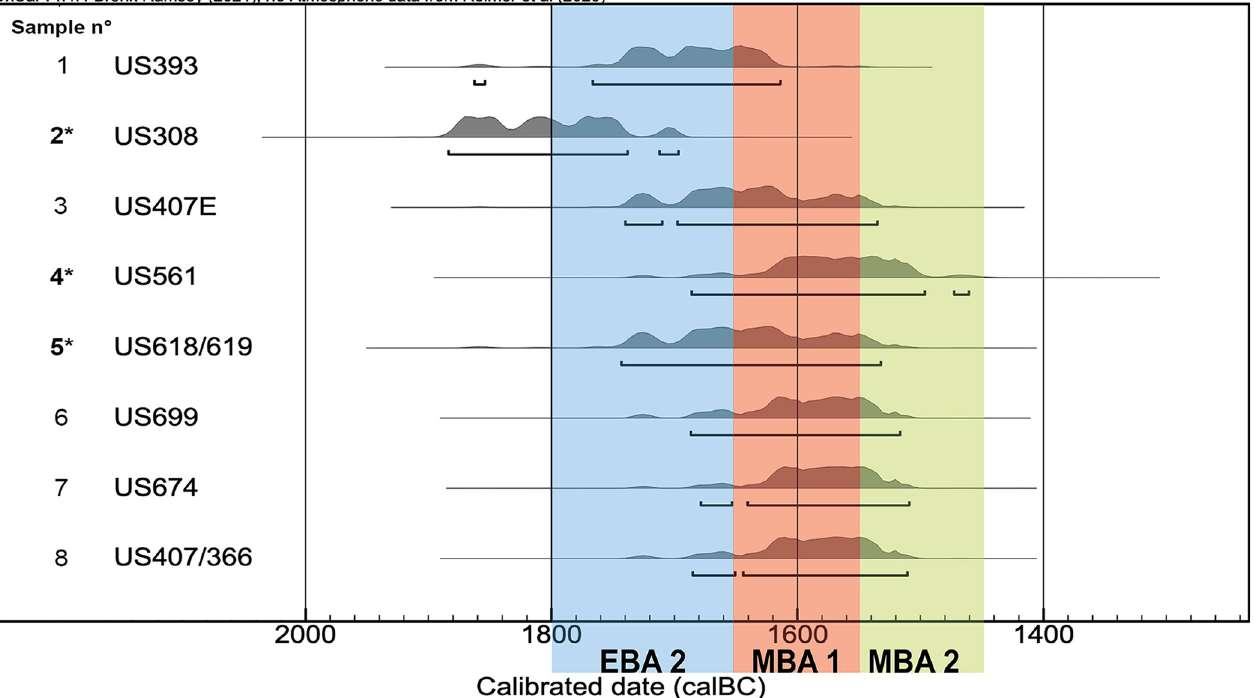
Fig 2. Radiocarbon dates related to the phase 2 of the site Oppeano 4D. Samples 2 and 5 = structure E; Sample 4 = structure F. The remaining samples come from other structures within phase 2 (see Fig 3): 1 (structure A);3, 8 (structure L); 6 (structure C); 7 (structure G). Bronze Age chronology based on [41]. See S2 Table for 14 C dates and sample